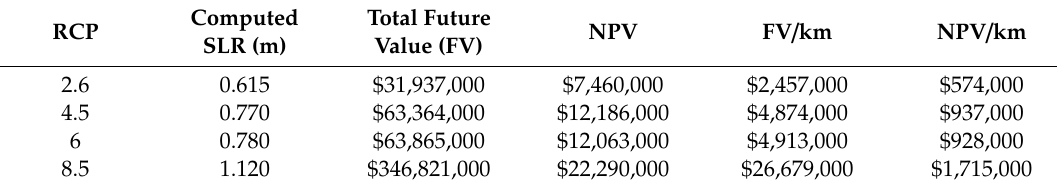
Table 6. Costs of coastal protection between 2020 and 2100 (2016 USD) (r = 3%; inflation = 1.7%). Computed RCP SLR (m)